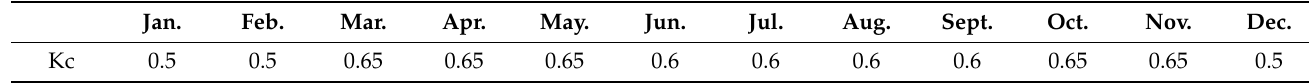
Table 1. Monthly variation of the Kc